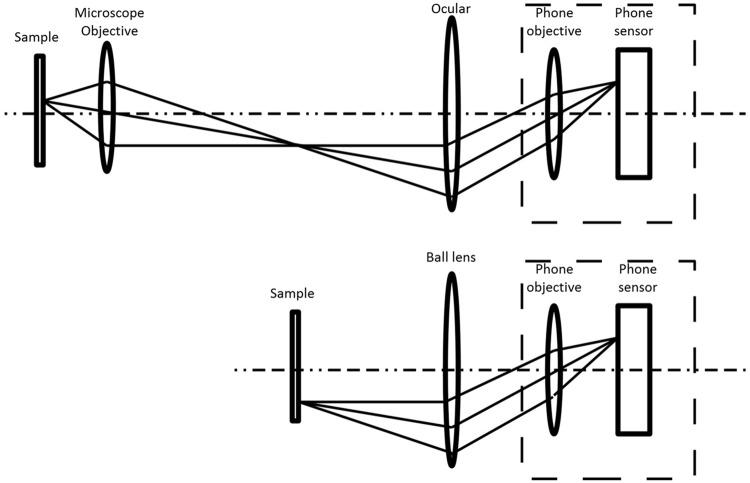
Cellphone camera coupled to classical microscope (top), and used as a tube lens coupled to external micro-objective (bottom).